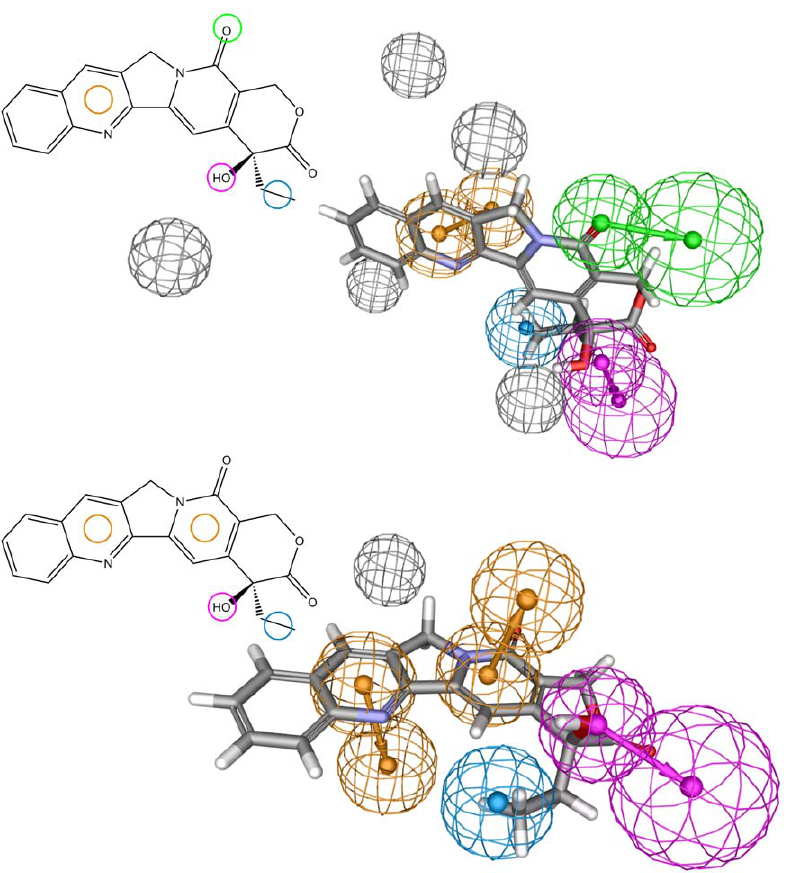
Figure 2. Ligand-based pharmacophores for camptothecin derivatives. 2D and 3D representations of the first (A) and second (B) pharmacophore hypothesis and their mapping to camptothecin. Cyclic p -interaction (CYPI) features are shown in orange, hydrogen bond acceptor (HBA) features in green, hydrogen bond donor (HBD) features in pink, hydrophobic (HYD) features in blue, and excluded volumes in gray. Mesh spheres in the 3D representations symbolize location constraints, with the second sphere for CYPI, HBA and HBD features showing the proposed location of the interacting atoms of the target (protein or DNA). Camptothecin in the 3D representation is shown in colour-coded sticks (carbon: gray, hydrogen: white, nitrogen: blue, oxygen: red).